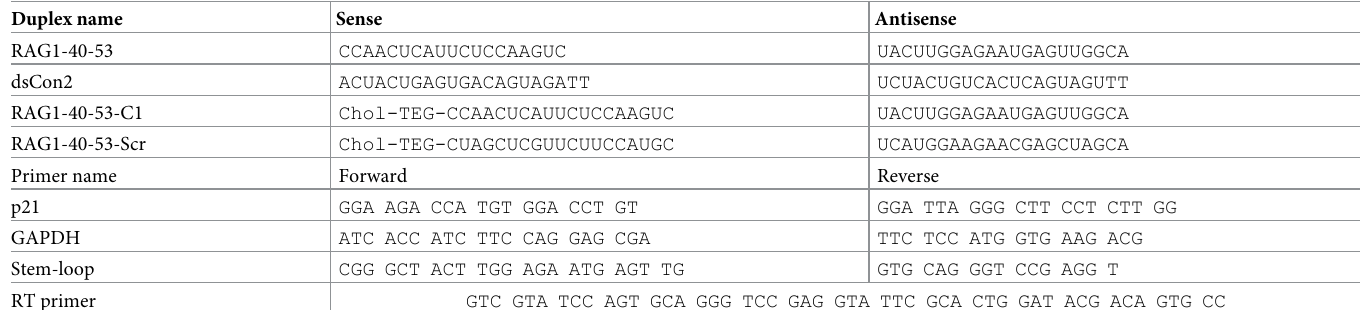
Table 1. Sequences of oligonucleotides and PCR